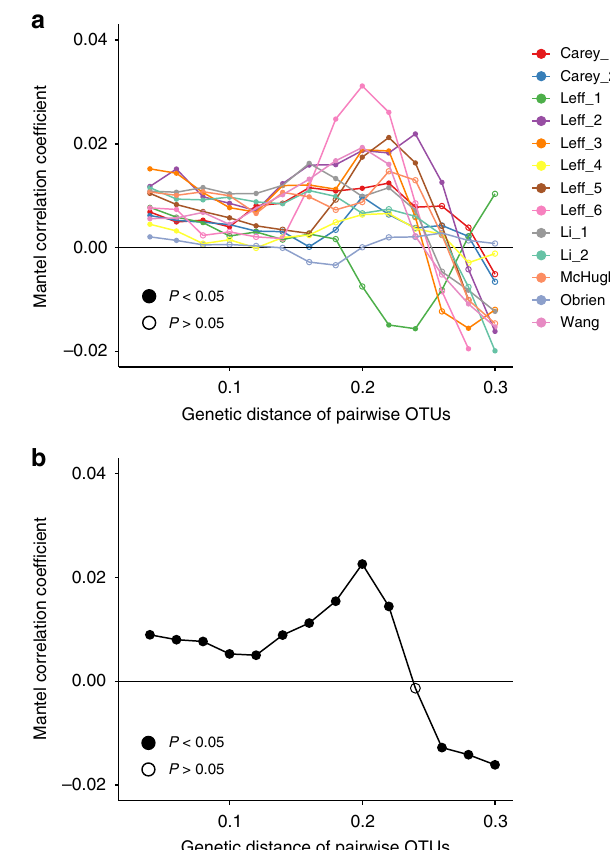
Fig. 2 Mantel correlograms showing the difference in response versus genetic distance of pairwise OTUs. a Response of bacterial OTUs to N addition at each location and b the averaged response across locations of widespread OTUs (i.e., present at fi ve locations or more) ware analyzed. Filled symbols represent genetic distance classes in which the autocorrelation coef fi cient signi fi cantly differs from